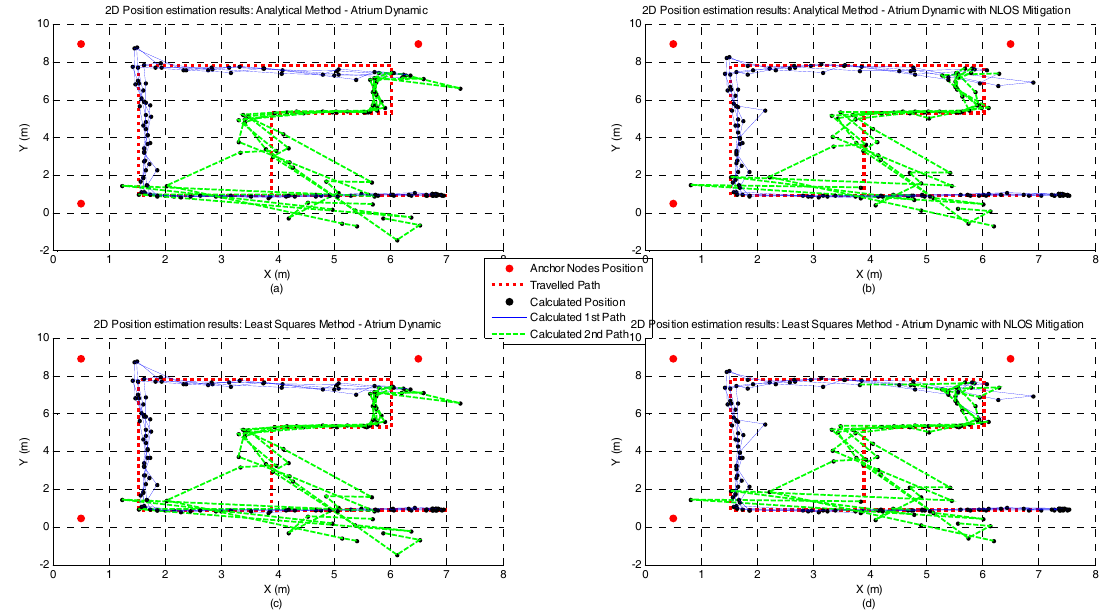
Figure 10. Atrium Dynamic test with Analytical ( a , b ) and Least Squares ( c , d ) methods and with and without NLOS identification and mitigation.